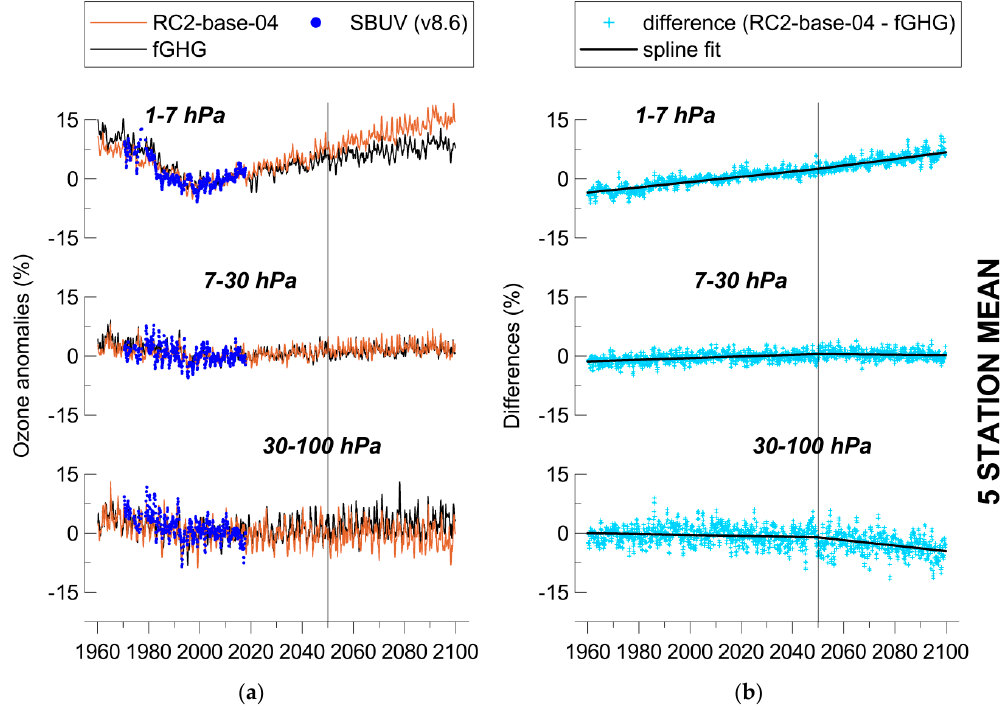
Figure 5. ( a ) Observed and simulated ozone changes. Model simulations refer to two free-running CCM simulations, a reference simulation with increasing GHGs emissions according to RCP-6.0 (RC2-base-04) and the same simulation with fixed GHGs emissions at 1960 levels (SC2-fGHG-01). ( b ) Differences (in %) between the two model simulations. The anomalies are deseasonalized data averaged at five stations: HHP–OHP–TMO–MLO–LAU.